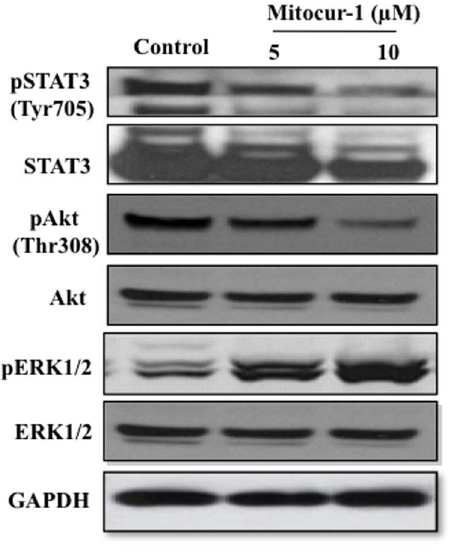
Figure 6. Mitocur-1 causes inhibition of Akt and STAT3 signaling and increase the ERK1/2 phosphorylation. MCF-7 cells were treated with Mitocur-1 (5 or 10 m M) for 16 h and subjected to Western blot analysis as described in Methods. Representative immunoblot images of STAT3, phosphorylated STAT3 (Tyr705), Akt, phospho-Akt (Thr-308), ERK1/2 and phospho- ERK1/2 are shown.